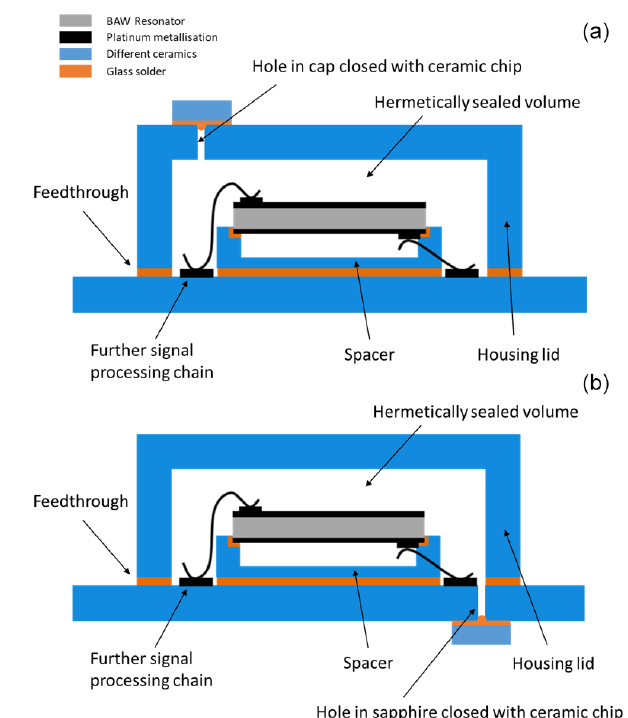
Figure 1. Schematic diagram of the sensor set-up as a temperature sensor. (a) A hole in a ceramic cap sealed with a Al 2 O 3 chip and glass solder. (b) A hole in sapphire sealed with a Al 2 O 3 chip and glass